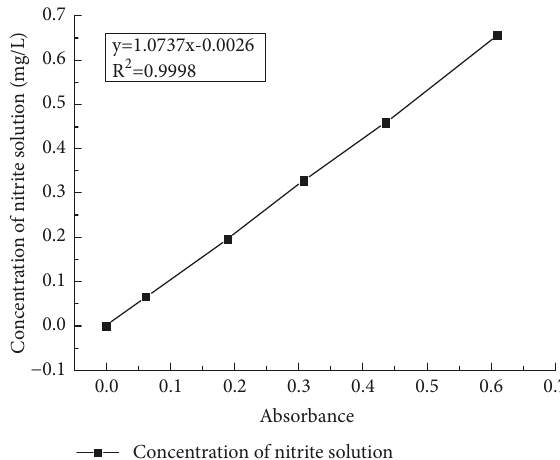
Figure 1: Calibration curve of absorbance and concentration of nitrite solution.